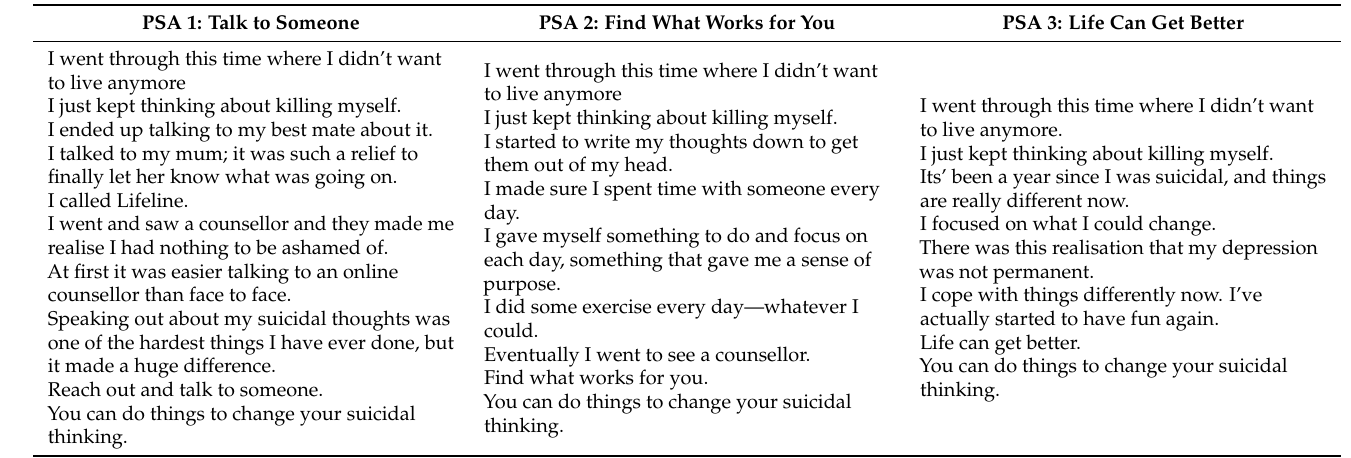
Table 3. Final suicide prevention media PSA